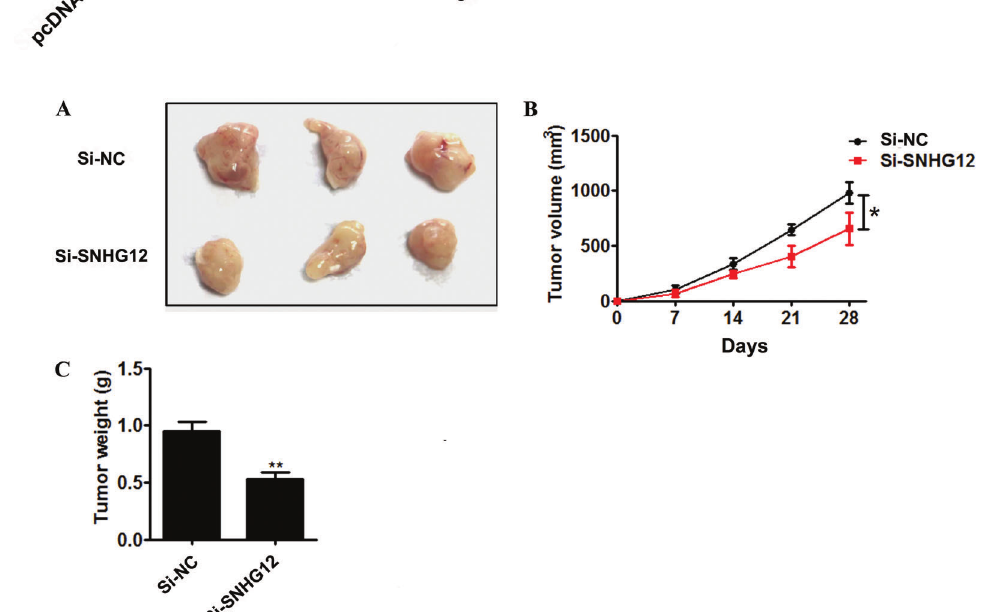
Figure 7. Effect of SNHG12 knockdown on colorectal cancer tumor growth in vivo . The subcutaneous xenotransplanted tumor model of HT29 cells in nude mice was established. HT29 cells were transfected with si-NC (n=6) or si- SNHG12 (n=6). A , tumors in mice inoculated with HT29 cells treated with si-NC or si- SNHG12 . B , tumor size in the two groups. C , tumor weight in the two groups. Data are reported as means ± SD. *P=0.05, **P o 0.01 vs control (Student ’ s t